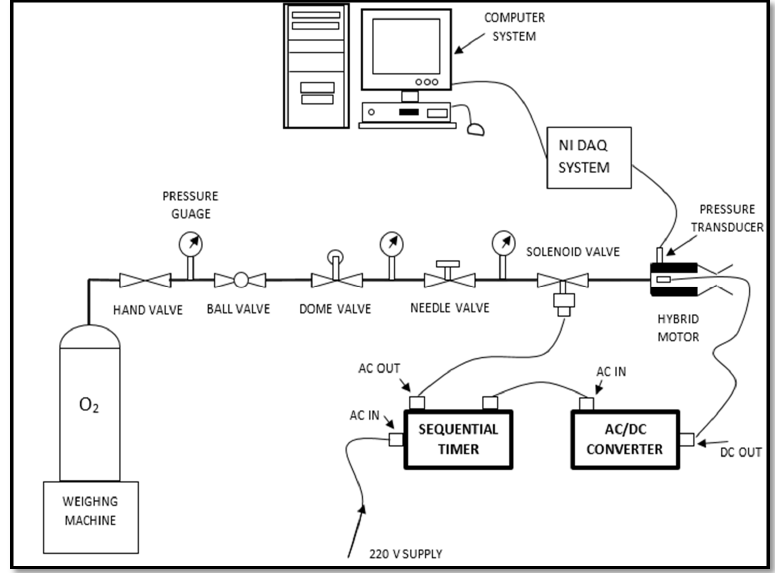
Figure 1. Complete layout of the experimental set-up.